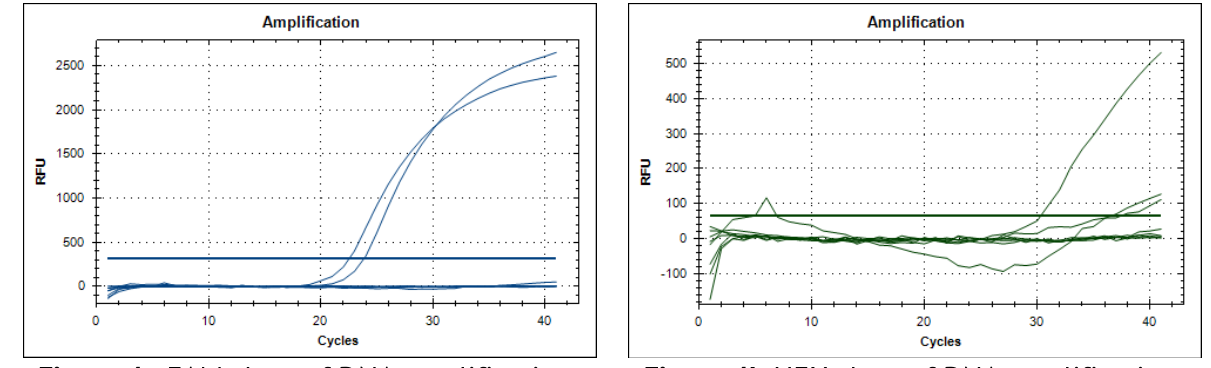
Figure 4b HEX chart of DNA